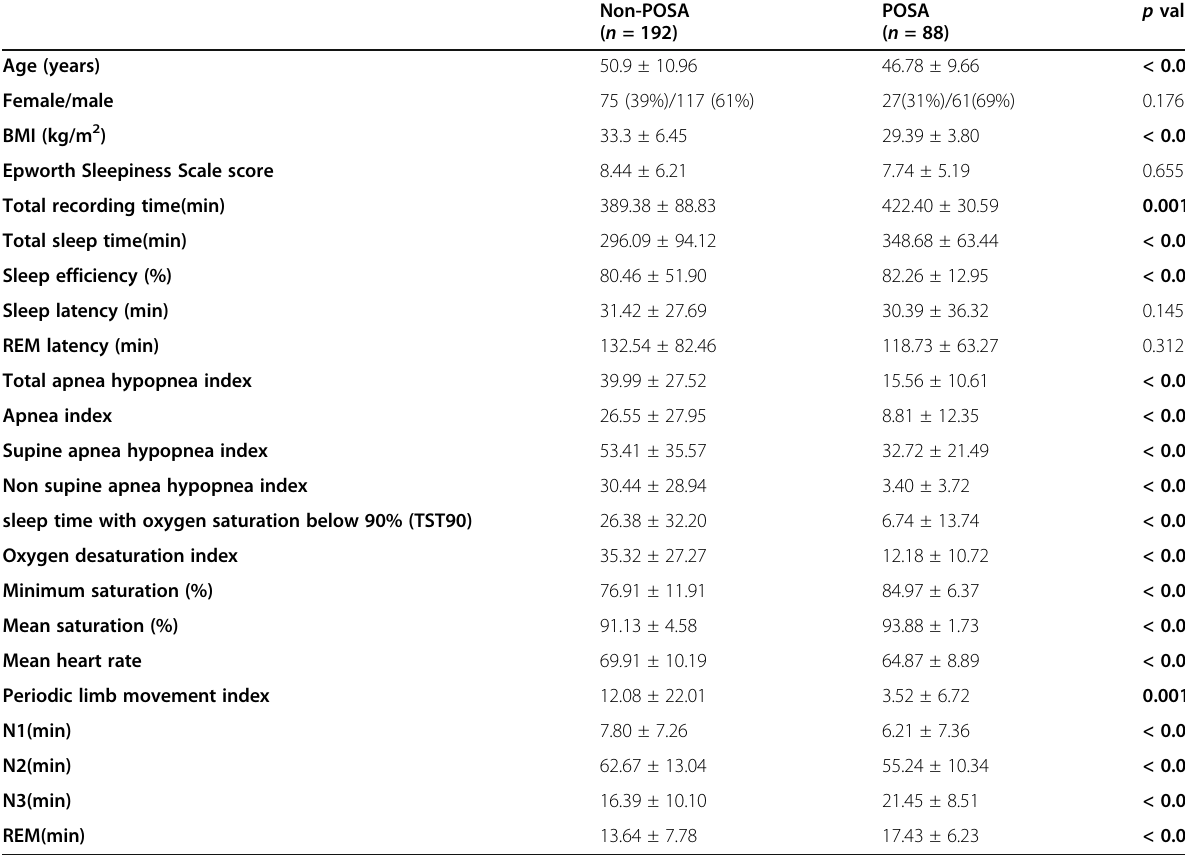
Table 1 Demographic and polysomnographic characteristics of OSA